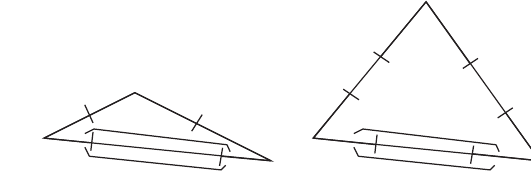
Figure 12: Cell inversion stops .